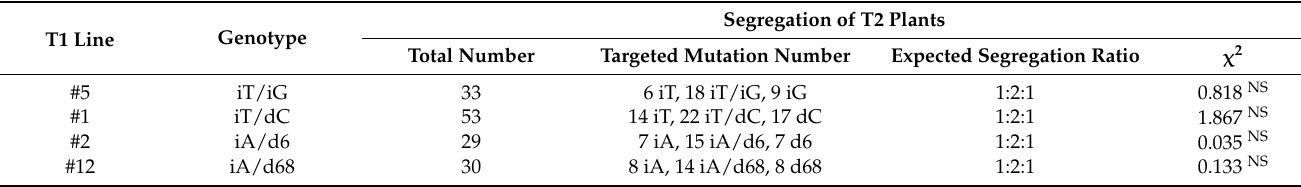
Figure 2. Genotype detection of offspring plants of bi-allelic T1 lines using AS-PCR. ( A ) Bi-allelic mutant line of #5 (iT/iG) with T insertion in one allele and G insertion in another allele; ( B ) bi-allelic mutant line of #1 (iT/dC) with T insertion in one allele and C deletion in another allele; ( C ) bi-allelic mutant line of #2 (iA/d6) with A insertion in one allele and 6 nucleotides deletion in another allele; and ( D ) bi-allelic mutant line of #12 (iA/d68) with A insertion in one allele and 68 nucleotides deletion in another allele. M, DNA marker; Kit, wild type rice Kitaake; and 1–21, partial plants of T2 segregation population. The primers are shown in Table 1. Table 3. The segregation and Chi-square of offspring genotypes in bi-allelic mutant lines.